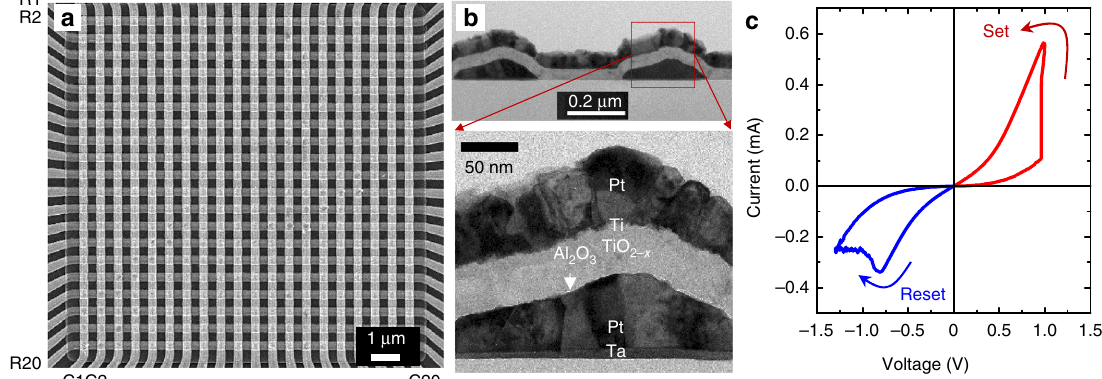
Fig. 1 Passive memristive crossbar circuit. a A top-view SEM and b cross-section TEM images of 20 × 20 Pt/Al 2 O 3 /TiO 2 − x /Ti/Pt crossbar circuit; c A typical I – V switching